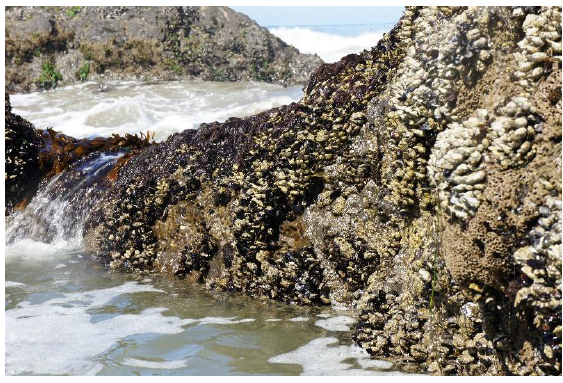
Figure 1. Mussels and other marine sessile organisms such as mussels anchored to mineral